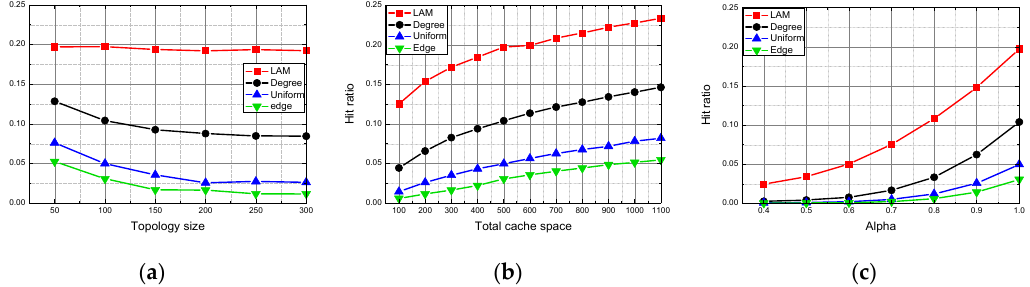
Figure 8. Performance of cache hit ratio in cache allocation. (a)The cache hit ratio under different topology sizes. (b)The cache hit ratio under different total cache space. (c)The cache hit ratio under different Zipf parameter Alpha.